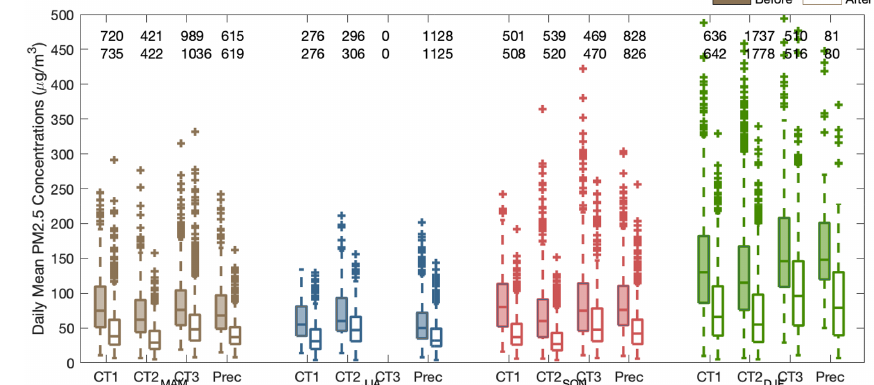
Figure 9. Distribution of the daily mean PM 2 . 5 concentrations before and after the occurrence of decay processes of pollution episodes in the 28 pollution channel cities. The hollow box indicates the concentration on the decay phase day, and the solid box is the value on the previous day. The relative differences in the PM 2 . 5 concentrations after the occurrence of a decay process are summarized in Table 2. The number at the top of each box indicates the sample size used for the boxplot. The number in the first line is the sample size of the “before” case, and the second line is for the “after” case.